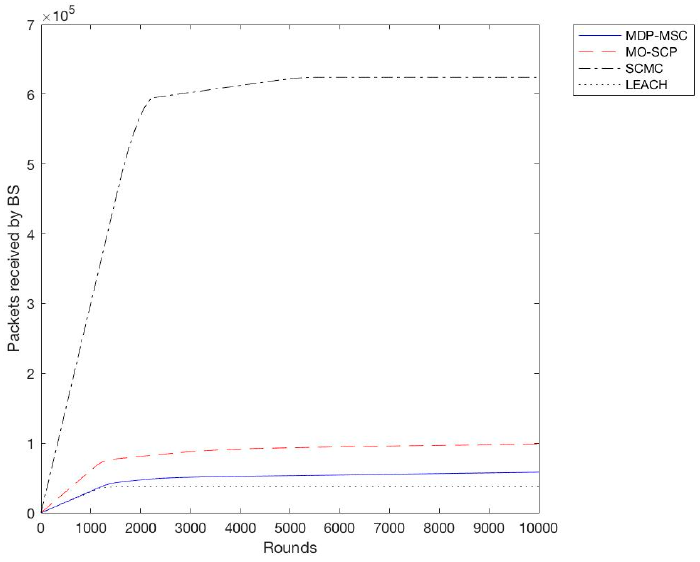
Figure 8. Throughput comparison of SCMC, MO-SCP, MDP-MSC and LEACH. (Size = 300).